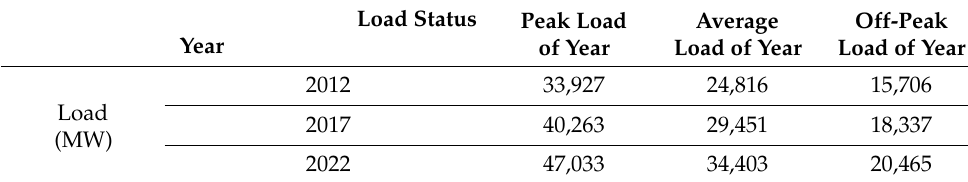
Table 2. The load of the TPC system in different horizon